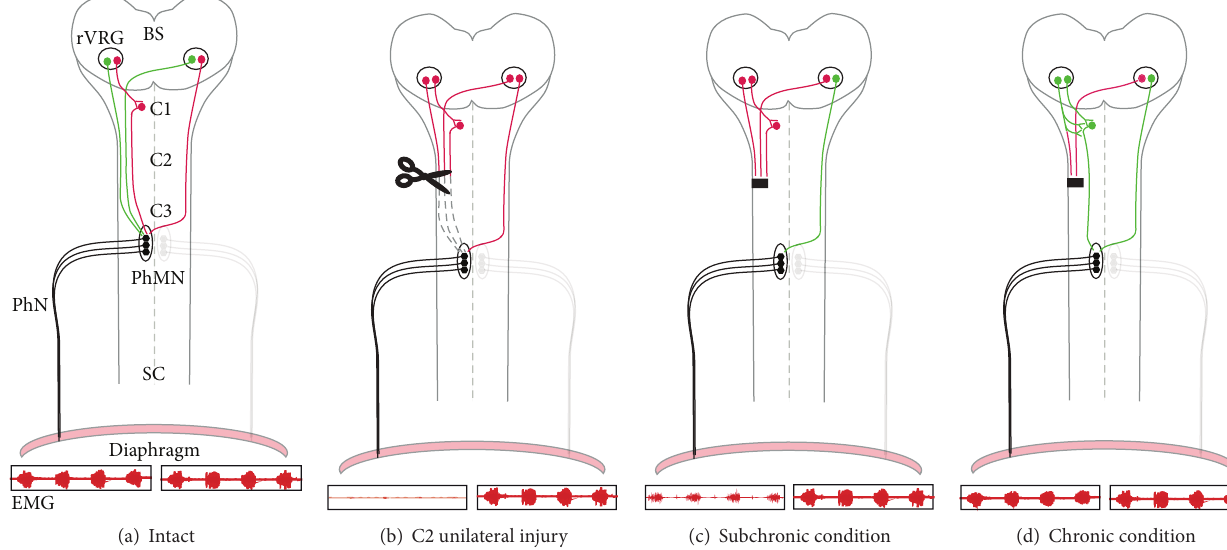
Figure 1: Diagram showing the spontaneous neural plasticity of the respiratory drive after cervical spinal cord injury. Green color represents active neural network. Red color represents silent or inactive neuronal network. (a, b) Unilateral injury leads to inactivation of ipsilateral premotoneurons from the brainstem or spinal cord (C1 interneurons). (c) In subchronic condition, the neurorestorative pathways include activation of CPP (contralateral premotoneurons in subchronic condition). (d) In chronic rerouting of unilateral premotoneurons through collateral connection to C1 interneurons. These last interneurons relay to phrenic motoneurons. BS: brainstem; C1–C3: cervical levels; EMG: electromyogram of hemidiaphragm SC: spinal cord; PMN: phrenic motoneuron; PN: phrenic